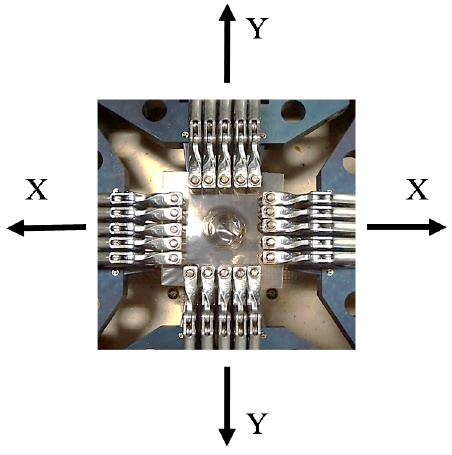
Figure 1. Photograph of clamps in a biaxial stretcher.